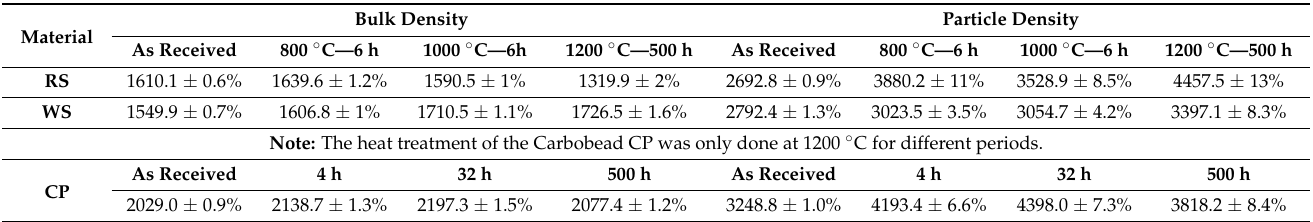
Table 7. Bulk density and particle density (kg/m 3 ) for particulate materials “as received” and after each thermal